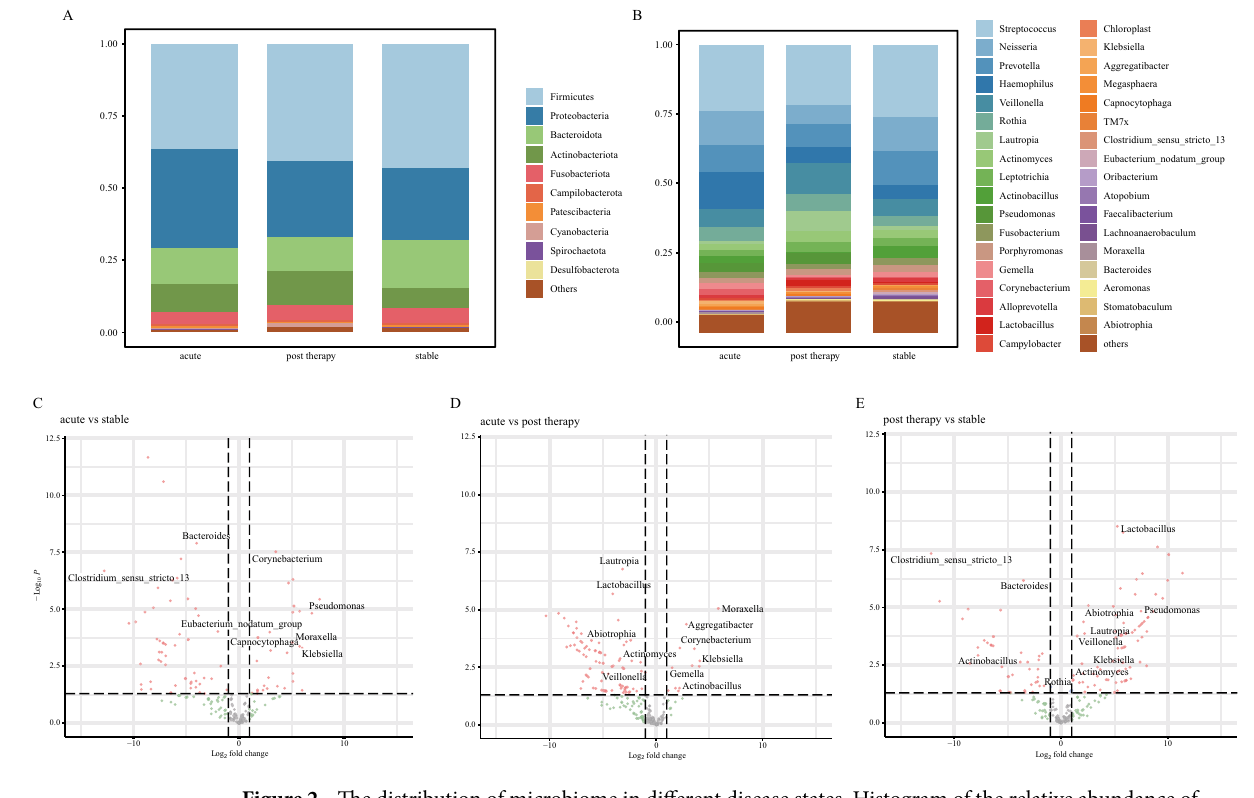
Figure 2. The distribution of microbiome in different disease states. Histogram of the relative abundance of the top 10 phyla ( A ) and the top 35 genera ( B ). ( C – E ) The volcanic plots of different taxa in three periods. Fold change is shown on the x axis and -log10 P (FDR corrected) on the y axis. Each dot in the diagram represents a sample. The red dots represent p < 0.05, | logFC |> 1; Green dots represent p > 0.05, | logFC |> 1; Blue dots represent p < 0.05, | logFC |< 1; Gray dot represents p > 0.05, | logFC |< 1. The black boxes represent the taxa that belong to top 35